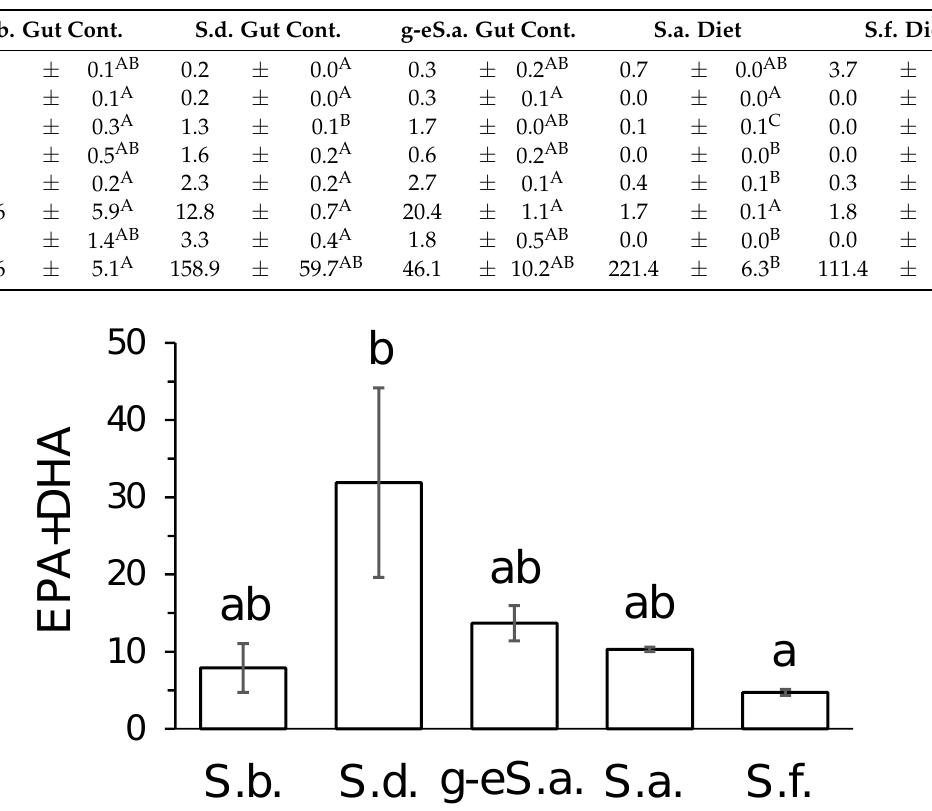
Figure 5. Mean values of contents (mg · g − 1 dry weight) of sum of eicosapentaenoic and docosahexaenoic fatty acids (EPA+DHA), in food of studied fish: gut content of boganid charr Salvelinus boganidae (S.b. number of samples, n = 2); Dryagin’s char Salvelinus drjagini (S.d., n = 5); goggle-eyed charr (the form of Salvelinus alpinus complex) (g-eS.a., n = 2); all from Lake Sobachye; diet of Arctic charr Salvelinus alpinus from the Ropsha farm (S.a. n = 5); diet of brook trout Salvelinus fontinalis from the aquaculture of Timiryazev Academy (S.f., n = 5). Means labelled with the same letter are not significantly different at p < 0.05 according to Kruskal–Wallis test. Bars represent standard errors.